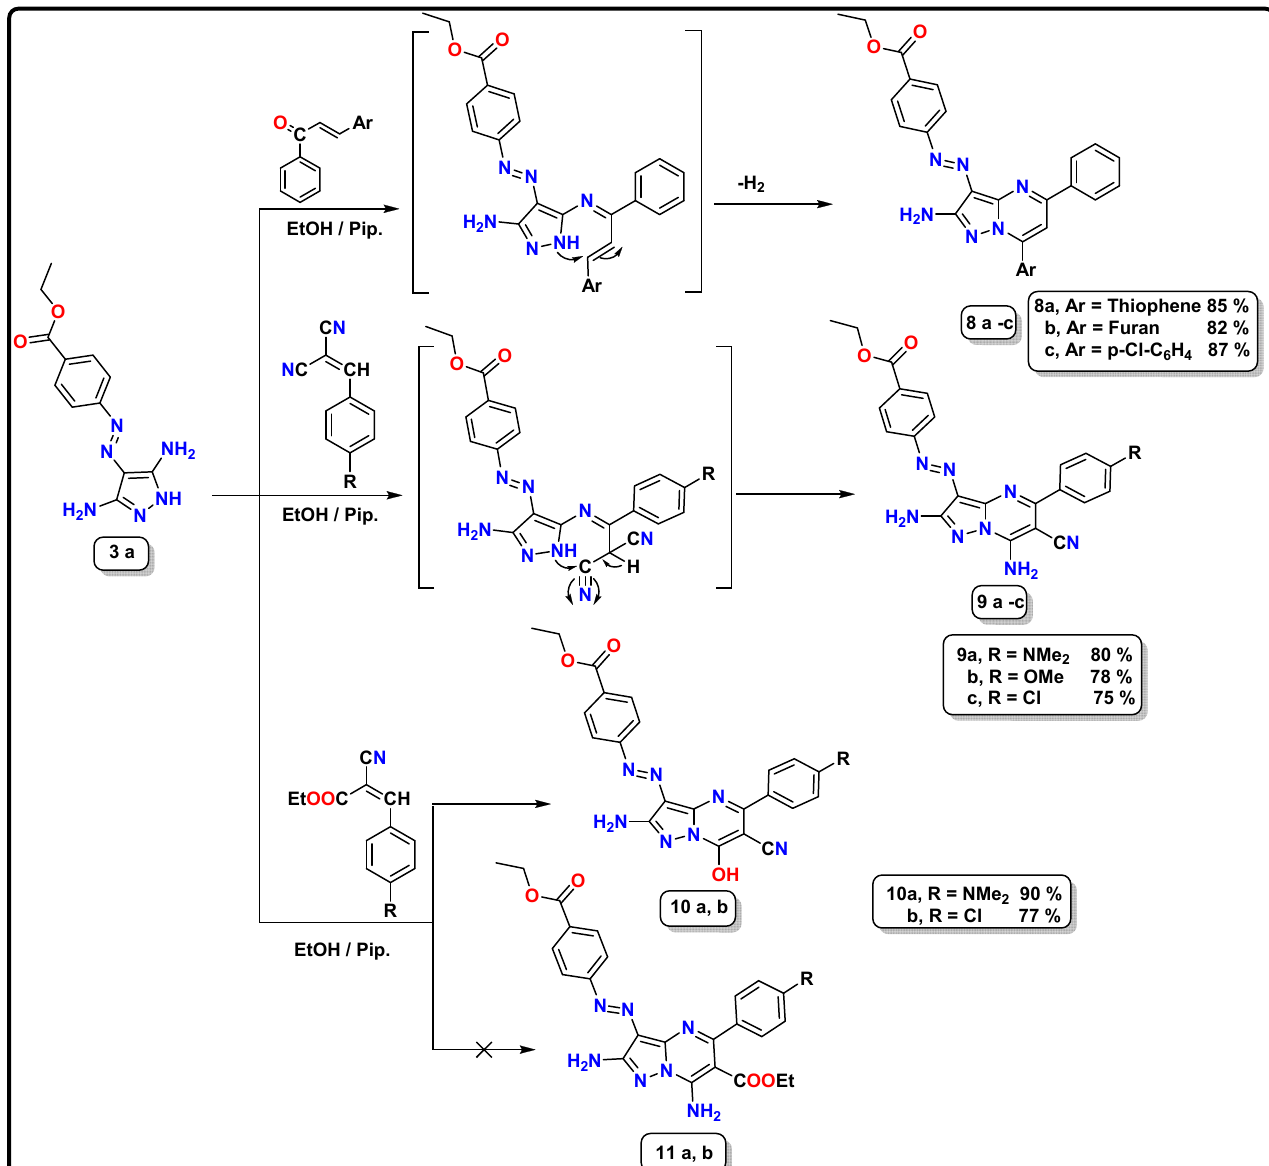
Scheme 3. Illustration of the pathway for the reaction of 3,5-diamino pyrazole 3 with some chalcone, arylidenemalonitrile, and ethyl cyanocinnamate